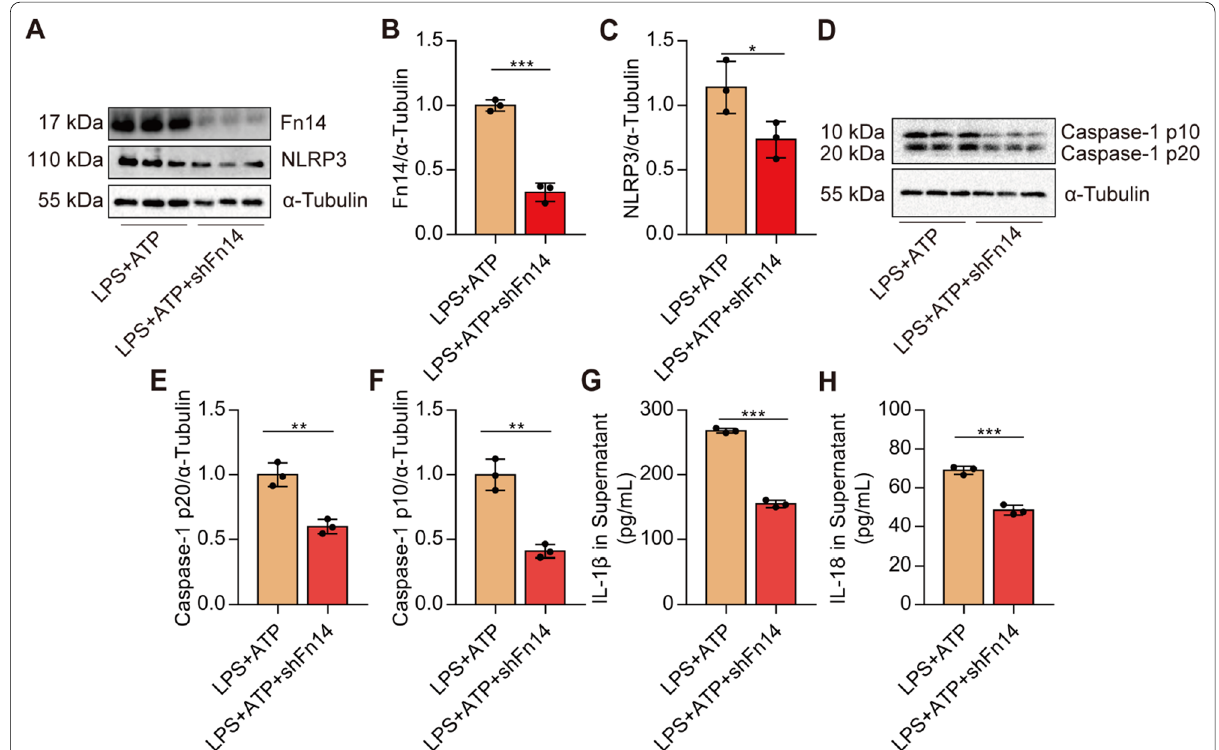
Fig. 8 The silence of Fn14 blocks the activation of NLRP3 inflammasome in macrophages. Fn14 shRNA was added before LPS (100 ng/ mL)‑challenged primary macrophages for 96 h. A–C The expressions of Fn14 and NLRP3 protein in primary macrophages were determined by Western blot ( n 3). D–F The levels of Caspase‑1 p20 and p10 in primary macrophages were determined by Western blot ( n = of IL‑1β in the supernatant of primary macrophages were determined ( n 3). H The contents of IL‑18 in the supernatant of primary macrophages = were determined ( n 3). Data are expressed as the mean SD. Differences between the two groups were determined by an unpaired t ‑test. = ± * P < 0.05, ** P < 0.01, and *** P <